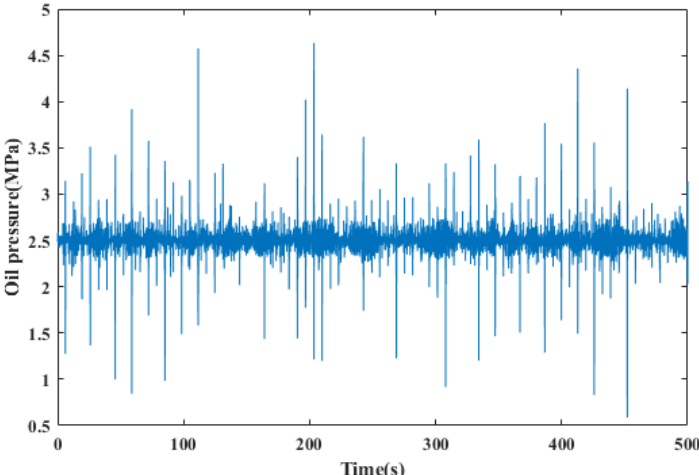
Figure 15. Test value of hydraulic oil pressure on flat terrain.